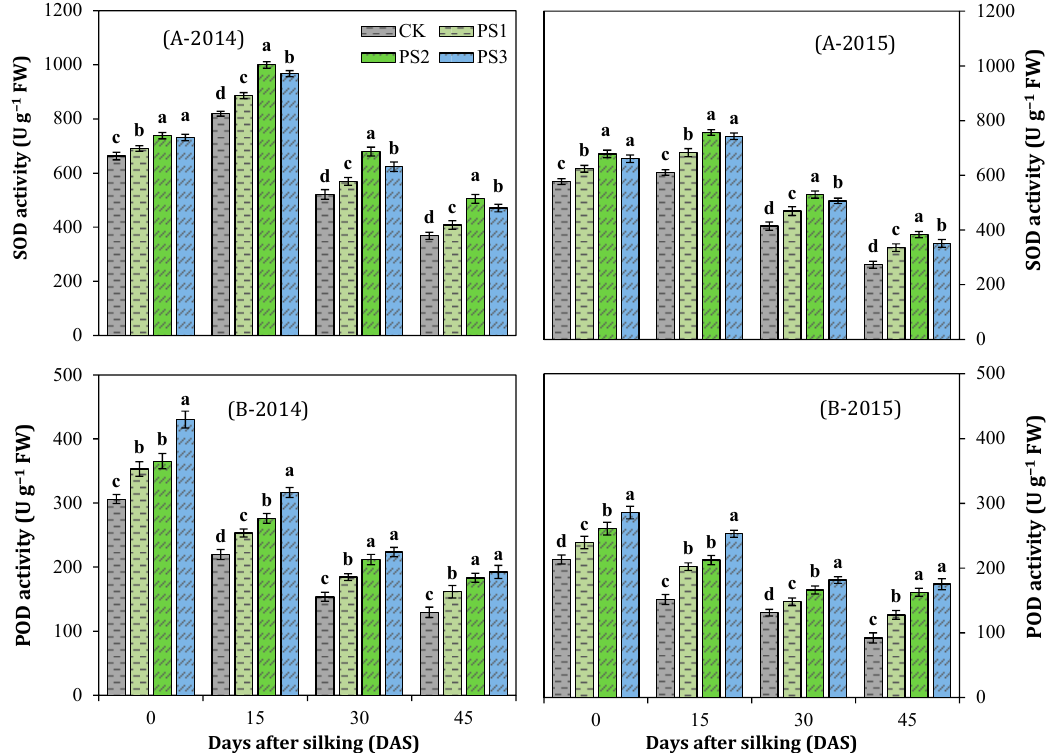
Figure 6. Effects of paclobutrazol treatments on ( A ) superoxide dismutase, SOD, and ( B ) peroxidase, POD, activity in maize leaves during 2014 and 2015. Data are presented as mean ± SD of three measurements. Different small letters on the bars indicate significant differences at P < 0.05 (LSD test). The abbreviations of treatment names are the same as those described in Figure 2.